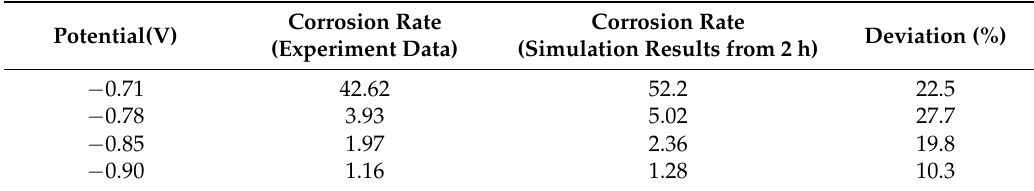
Table 2. Comparison between corrosion rate of weight loss experiment data and simulation